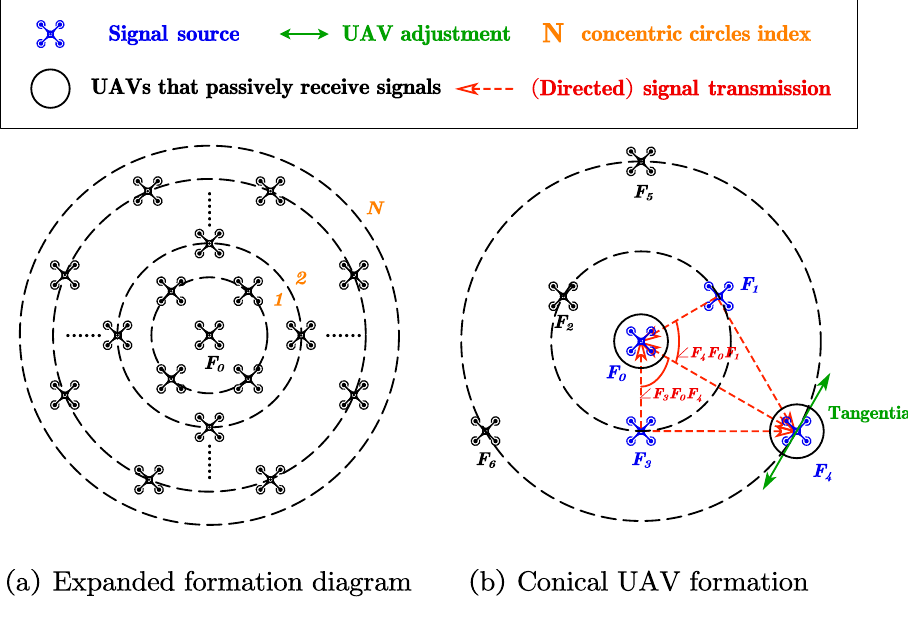
Figure 4. Expanded UAV